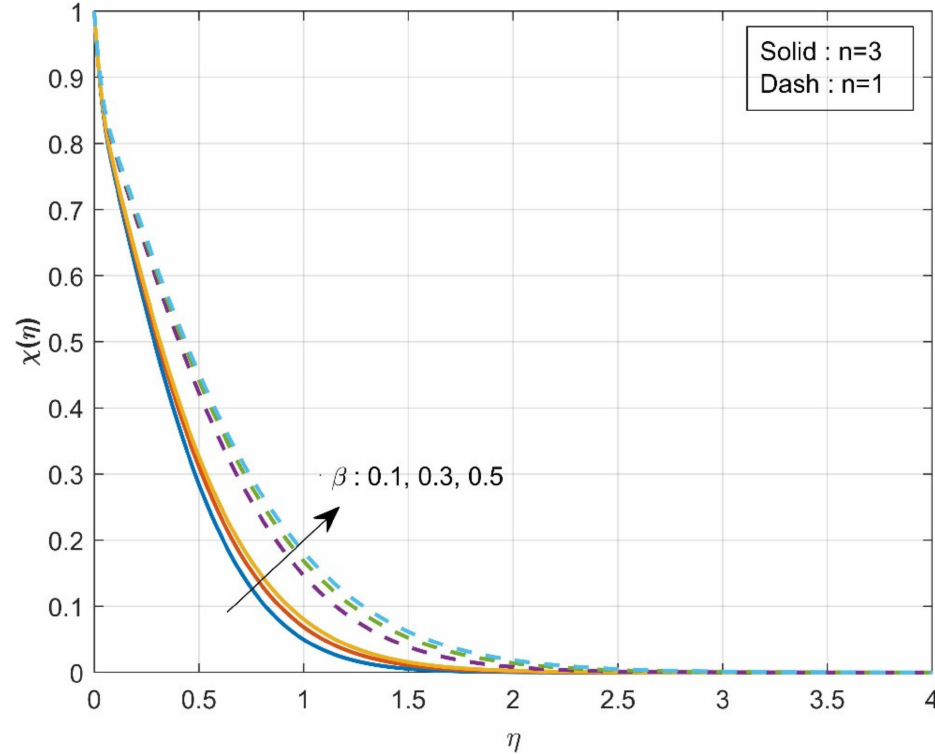
Figure 5. Influence of β over concentration χ ( η )